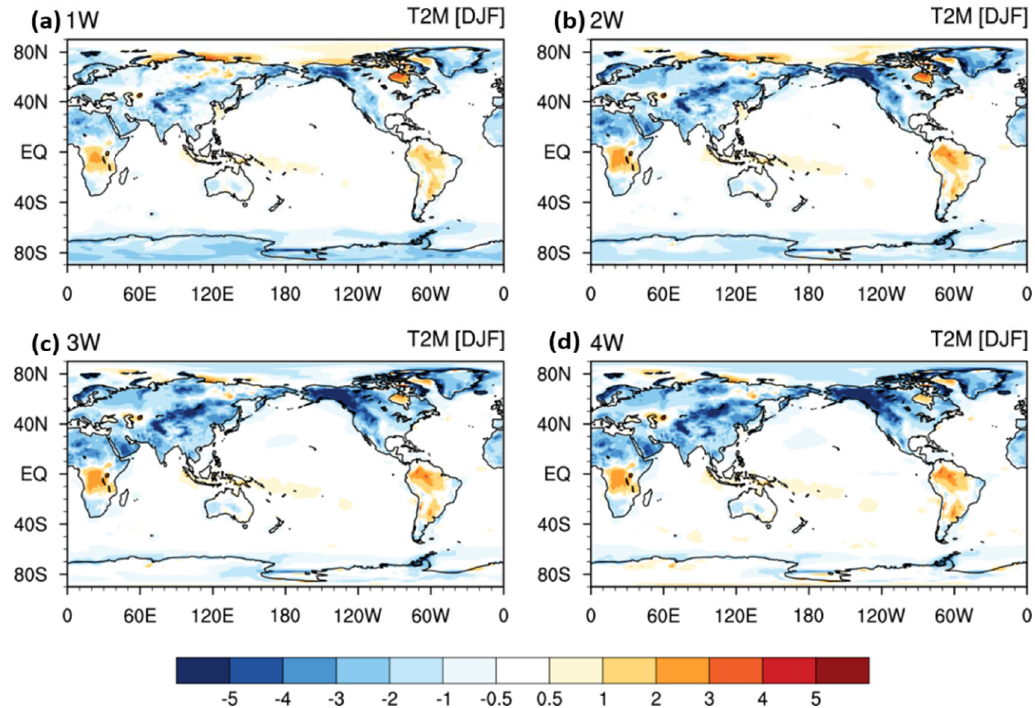
Figure 1. Spatial distribution of surface temperature biases (model minus ERA–Interim reanalysis) of ( a – d ) lead times of 1–4 weeks for 1991–2009 DJF.